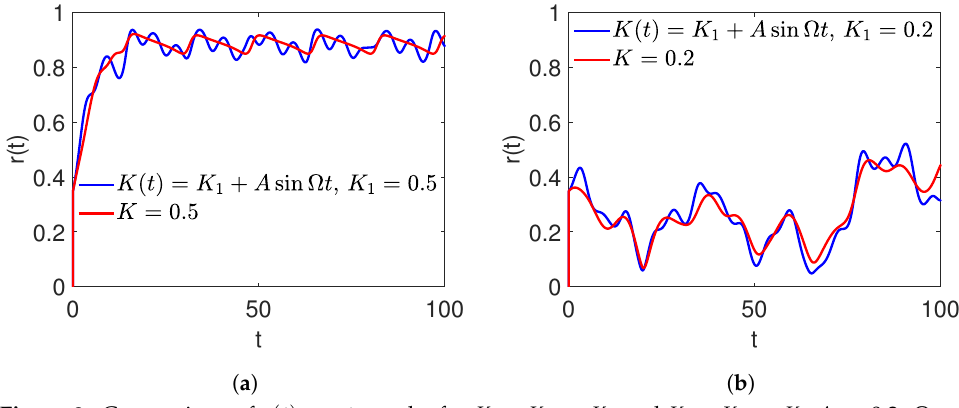
Figure 3. Comparison of r ( t ) vs. t graphs for K = K 1 < K c and K = K 1 > K c A = 0.2, Ω = 1. ( a ): Temporal evolution of r ( t ) for K = 0.5 = K 1 > K c . Results are identical for the time-dependent and uniform coupling strength. ( b ): r ( t ) vs. t comparison using K = 0.2 & K ( t ) with K 1 = 0.2. These graphs are fairly